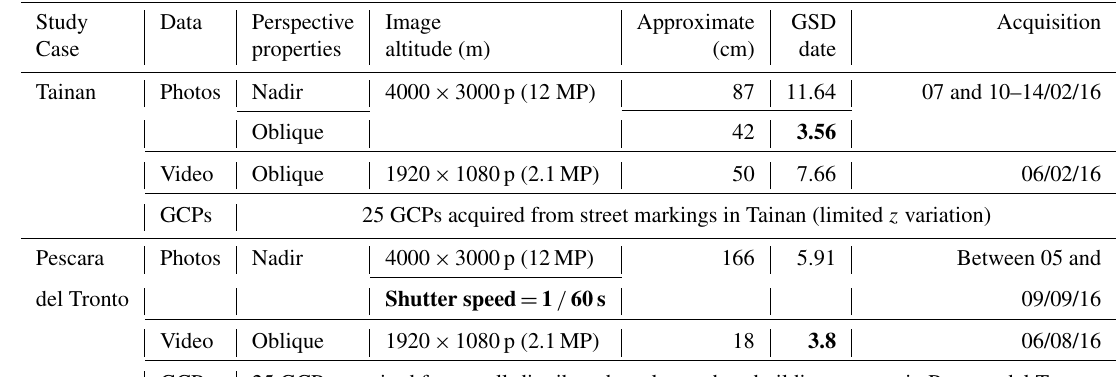
Table 1. Data obtained at the study sites. Highlighted are some data proprieties that are especially relevant for this research. Study